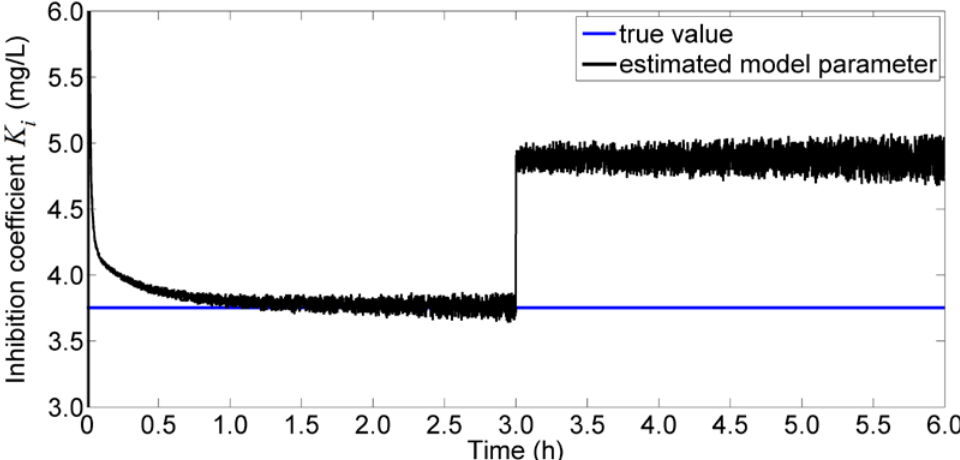
Figure 7. Estimated model parameter K i for faulty scenario 2.